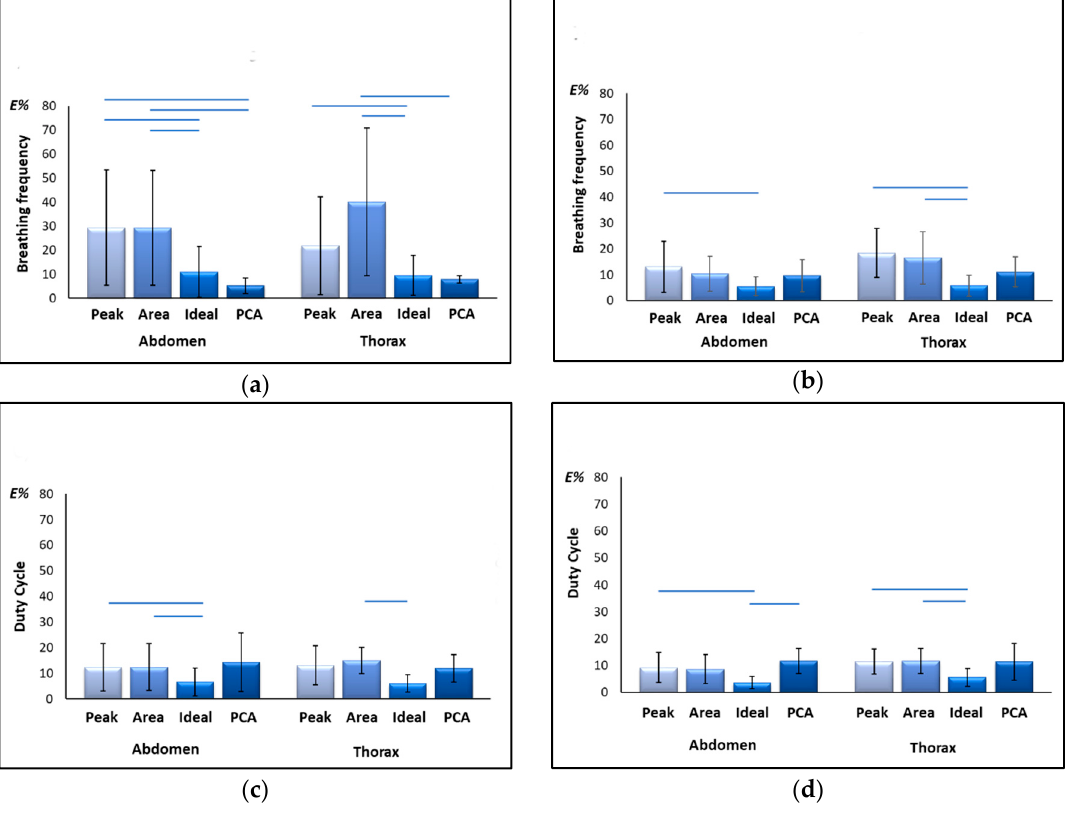
Figure 4. Relative errors (E%) of estimation of breathing frequency ( a , b ) and Duty Cycle ( c , d ) in supine ( a , c ) and seated ( b , d ) positions, computed for each method (Peak, Area and PCA) and for the “Ideal” component with respect to the reference (OEP). Errors are computed both for the Thoracic and abdominal compartments. Horizontal blue lines indicate statistical significance of difference (post-hoc analysis, Wilcoxon test FDR corrected).